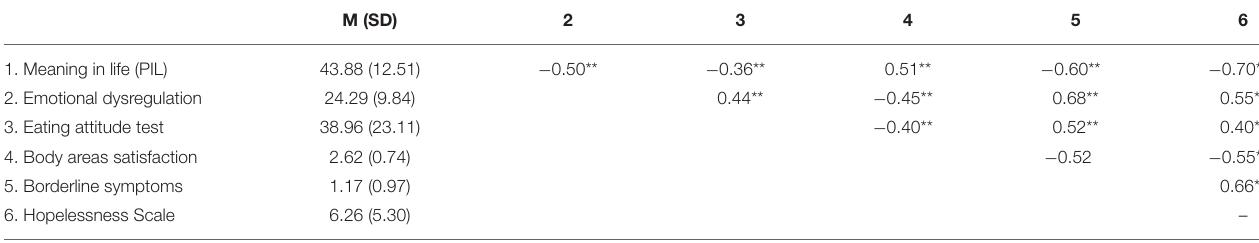
TABLE 6 | Mean and zero-order correlations for the variables in participants with ED. M (SD) 2 3